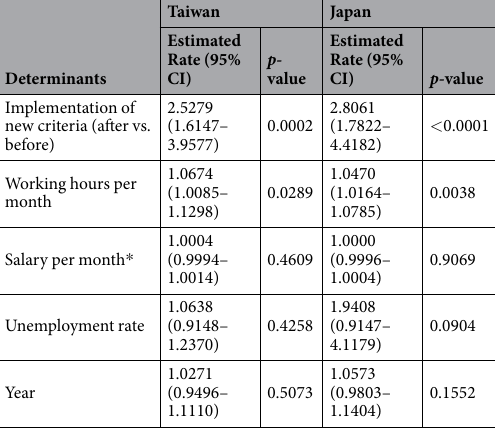
Implementation of new criteria (after vs. before) Country recognition system (Taiwan vs. Japan)